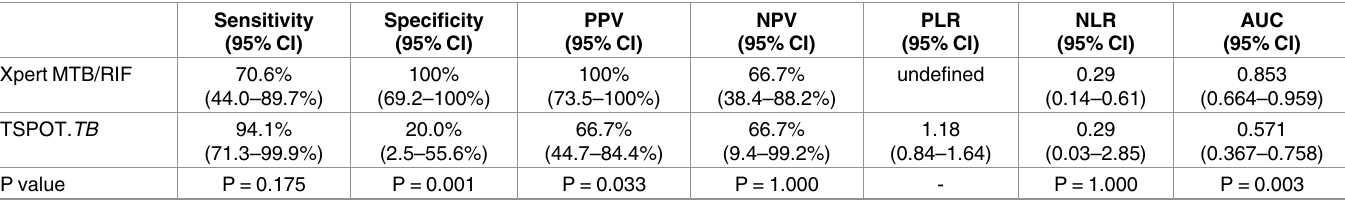
Table 3. Diagnostic value of Xpert MTB/RIF and TSPOT. TB tests, using that of CRS as a reference standard. P-values corresponded to statistical comparisons between Xpert MTB/RIF and TSPOT. TB tests. Sensitivity (95%